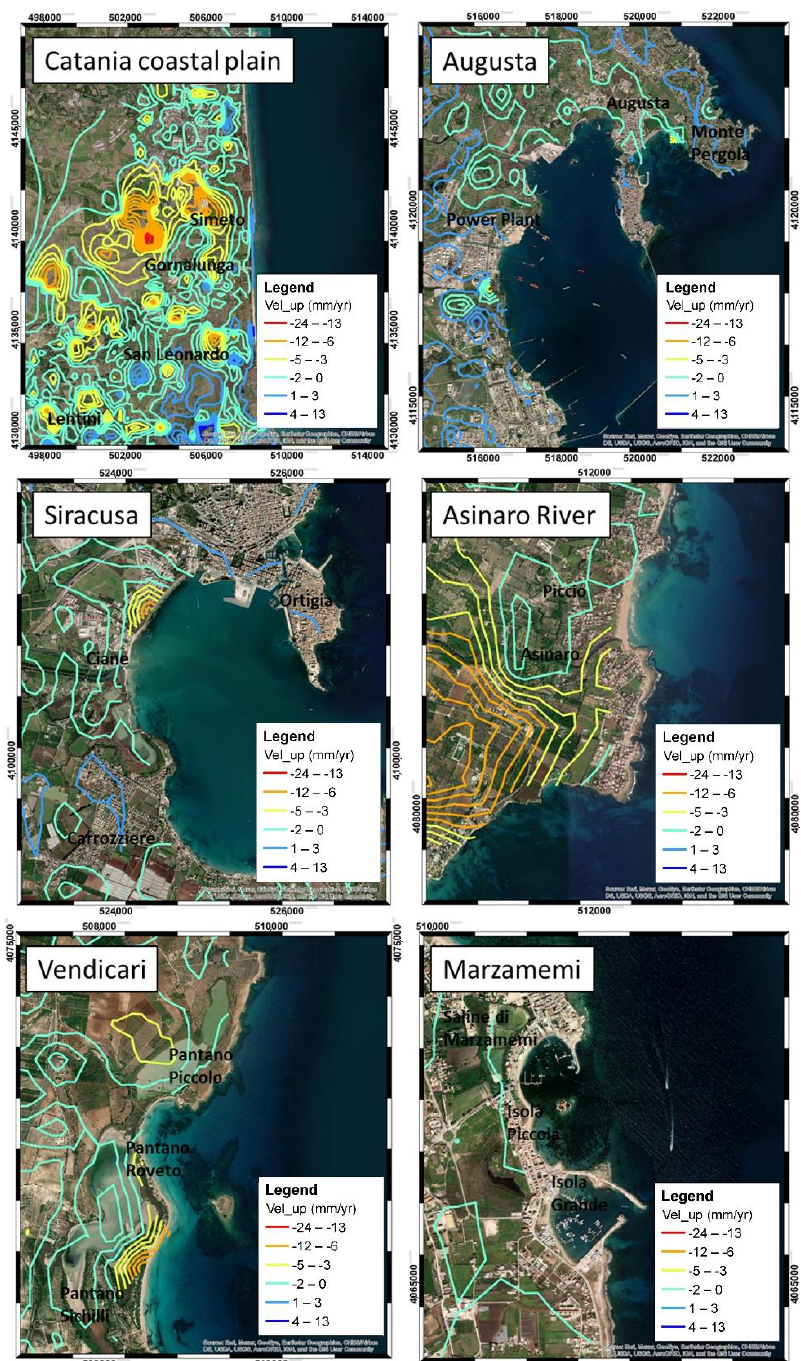
Figure 4. Vertical land velocities (contour in mm/yr) estimated in the time span 2015–2020 from the combination of InSAR ascending and descending orbits, for six investigated coastal zones (see Figure 2 for location).